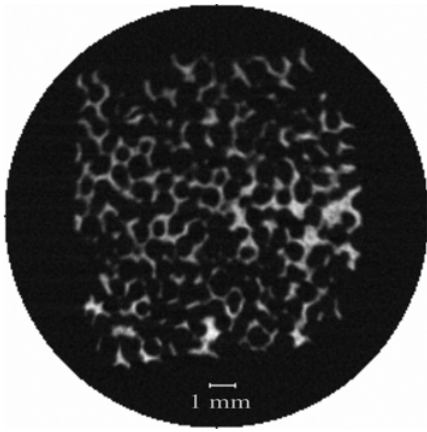
Figure 5. CT image of 90 ppi ceramic sample (5 × 9 mm 2 ) meas- ured at 28.3